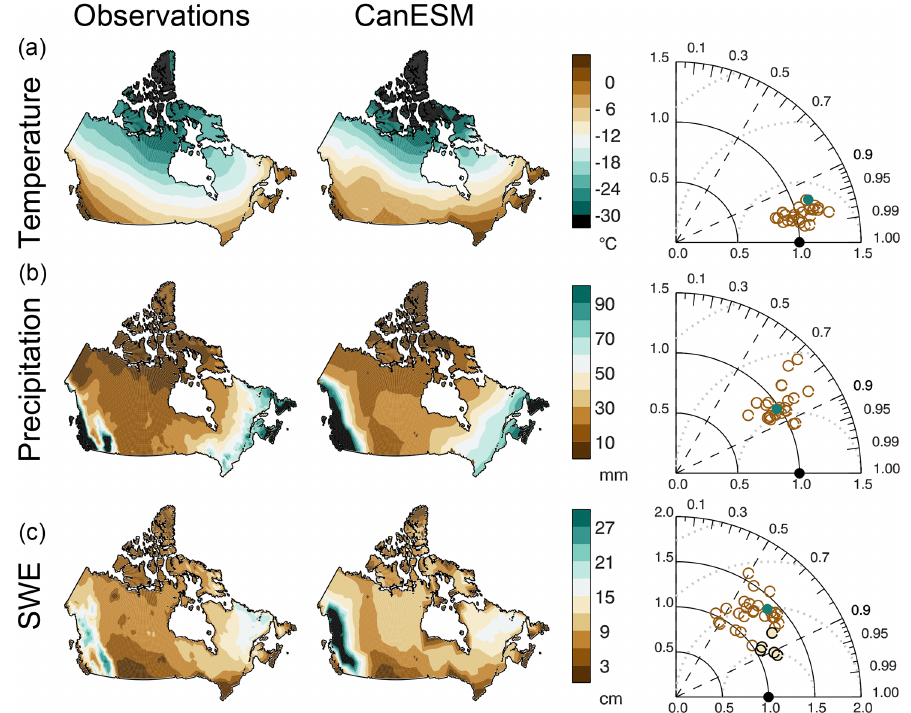
Figure 1. Comparison of simulated Canadian climate in CanESM2 with observations and other climate models for 1981–2005. The left column shows observed January–March (JFM) mean land-surface temperature ( a , left panel, HadCRUT4), precipitation ( b , left panel, CRU TS3.21), and snow water equivalent ( c , left panel, Blended-5 data). The central column shows the same fields as simulated by the ensemble mean of the CanESM2 large ensemble. Observations and the CanESM2 output have been mapped to a common grid that represents the model grid spacing. The right column plots are Taylor (2001) diagrams showing the correlation (related to the polar angle) and standard deviation relative to observations (distance from origin) of the patterns of these variables in observations (black dot), CanESM2 (green dot), and other CMIP5 climate models (brown circles). Models that are closer to the black dot representing the observations have smaller errors (standard error represented by dotted semicircles at intervals of 0.5). In the SWE Taylor diagram ( c , right panel), the filled light brown dots compare the individual Blended-5 datasets to the Blended-5